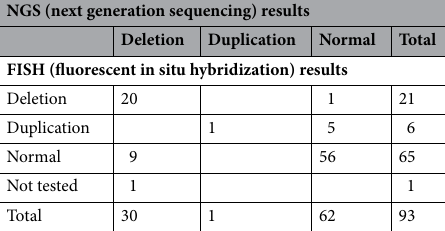
NGS (next generation sequencing)